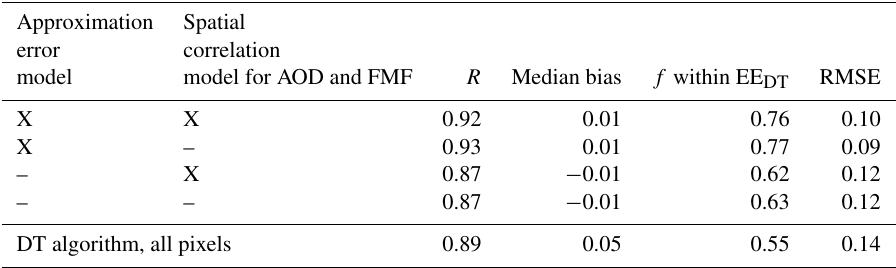
Table 2. Global statistics of AOD retrievals for Bayesian aerosol retrieval (BAR) run with different models. The models considered are the approximation error model and the spatial correlation model for AOD and FMF. X and – in the table indicate that the corresponding model was and was not included in the retrieval, respectively. All pixels were considered in the retrieval and each row correspond to data from 346 AERONET stations and 45240 collocated observations.